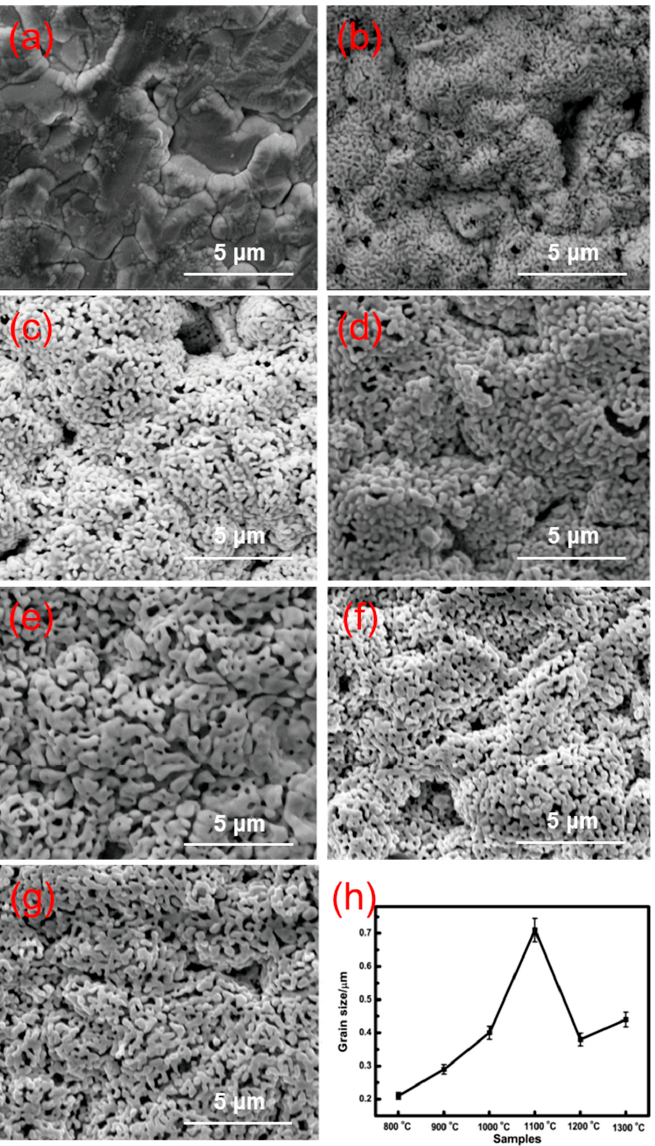
Figure 2. Surface morphologies of 0.2LSCO thin films annealed at different temperatures: ( a ) deposited; ( b ) 800 °C; ( c ) 900 °C; ( d ) 1000 °C; ( e ) 1100 °C; ( f ) 1200 °C; ( g ) 1300 °C; ( h ) the change in grain size with different post-annealing temperatures.